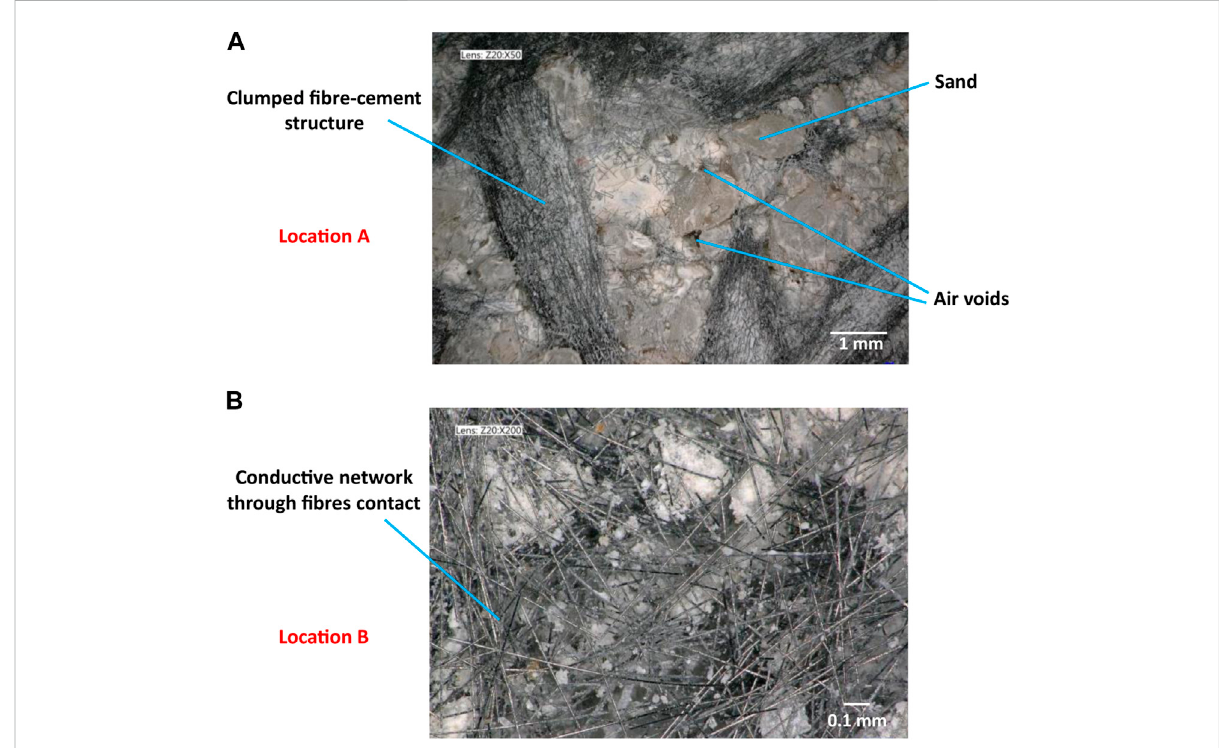
FIGURE 4 Digital microscope investigation on the fracture surface of CF2.4 vol% (A) location A where the fi bres were clumped, the sands were poorly bonded, and the mortar matrix showed poor homogeneity (B) location B where the fi bres were uniformly dispersed but still the mortar matrix showed poor